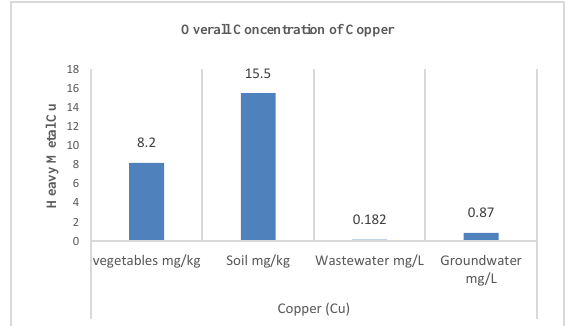
Figure 2: Overall Concentration of Copper